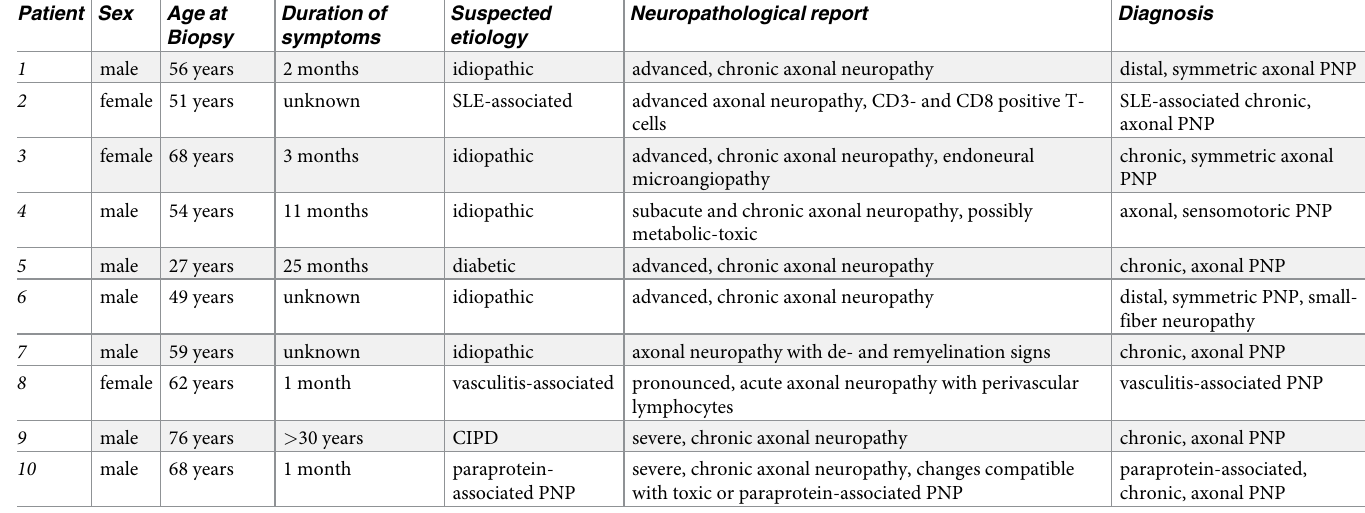
Table 1. Patient characteristics. 10 Patients with polyneuropathy undergoing diagnostic sural nerve biopsy were included in this study. Patient Sex Age at